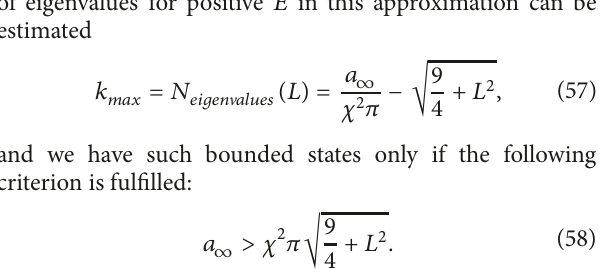
becomes imaginary, this tangent transforms into hyperbolic tangent. Consequently, for each value of 𝐿 the spectrum contains just one negative energy level. The last domain is for energy less than the limit written above, which represents unstable physical situations, and we will ignore it in the